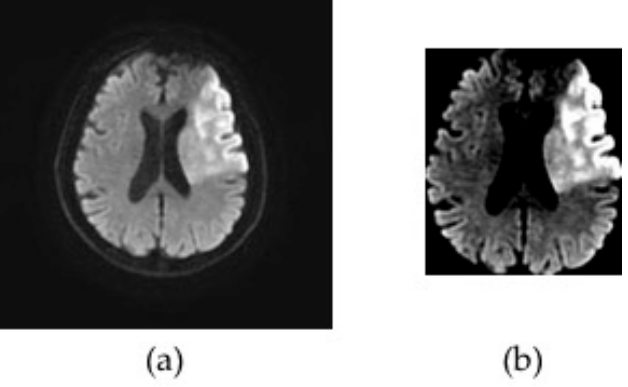
Figure 2. Representative diffusion-weighted magnetic resonance imaging (DWI) images illustrating the preprocessing step. The original DWI image ( a ) was cropped around brain parenchyma and a contrast stretching algorithm was applied to enhance the contrast of the DWI data ( b ).